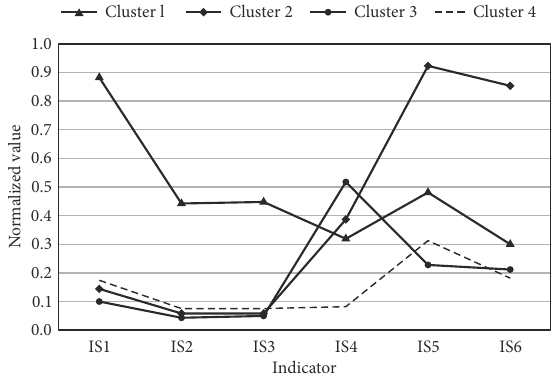
Table 4. Comparison of weighting results between SEWM and entropy weight.